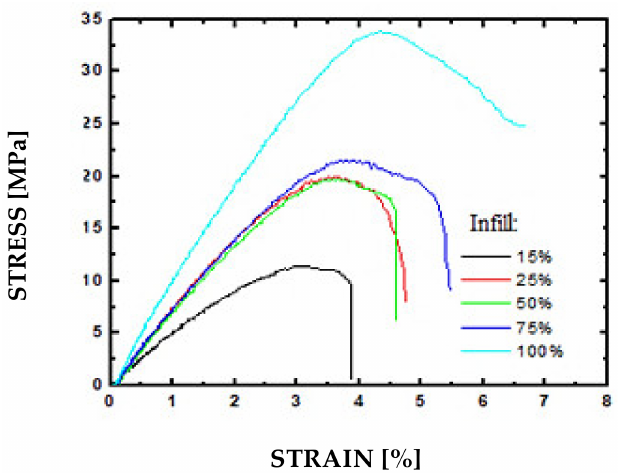
Figure 13. Engineering stress–strain curves for the di ff erent internal fill levels of 15%, 25%, 50%, 75%, and 100%. Table 2. Average and standard deviation results obtained from tensile test. Strain Yield Modulus of Breaking Group Maximum Stress Elasticity Elongation (MPa) (MPa) (MPa)